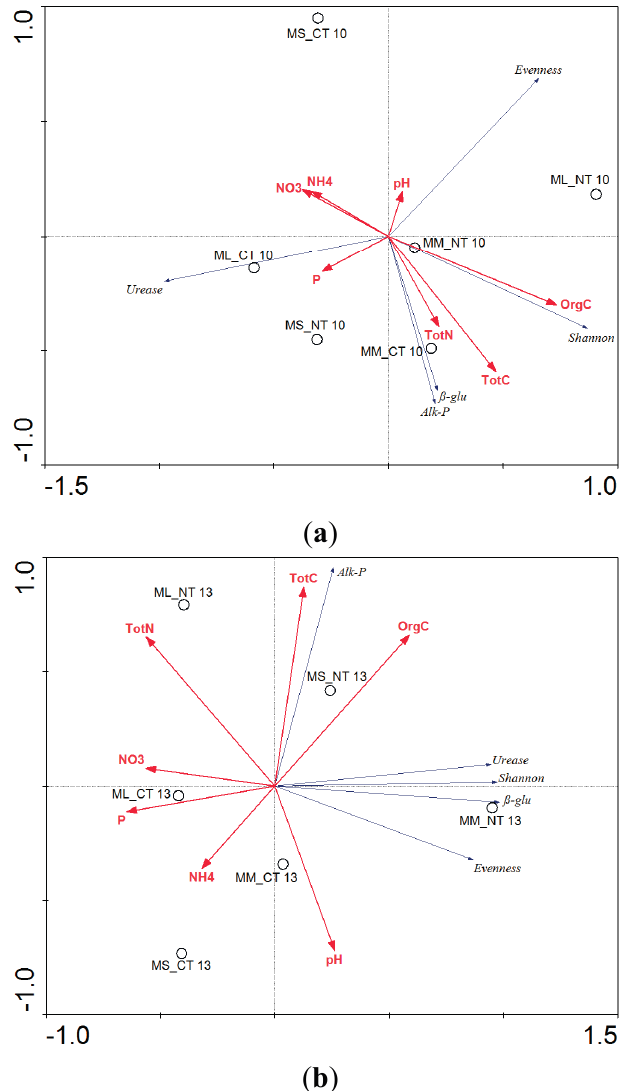
Figure 9. ( a ) Redundancy analysis (RDA) ordination diagram illustrating the relationship between the selected chemical environmental factors, soil microbial diversity and microbial activity of the different agricultural practices during the 2009/2010 planting season. ( b ) Redundancy analysis (RDA) ordination diagram illustrating the relationship between the selected chemical environmental factors, soil microbial diversity and microbial activity of the different agricultural practices during the 2012/2013 planting season. The chemical environmental factors are represented by the bold red vectors, and the biological factors are represented by the thin blue vectors. Environmental factors: OrgC (organic carbon), TotC (total carbon), TotN (total nitrogen), P (phosphorus). Biological factors: Shannon (microbial species richness), Evenness (microbial species abundance), β -glu ( β -glucosidase), Alk-P (alkaline